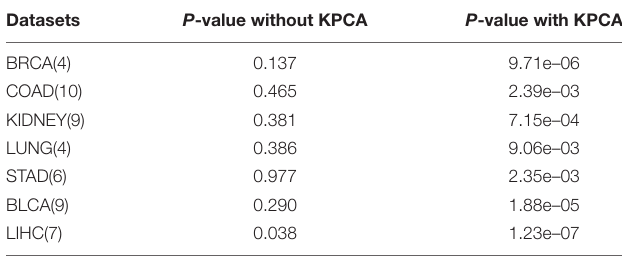
TABLE 2 | Results with or without kernel principal component analysis (KPCA).